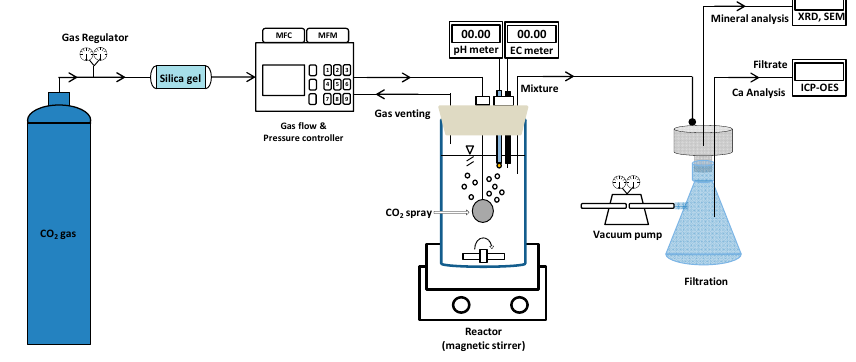
Figure 3. A schematic experimental flow diagram of the carbon mineralization process (MFC: mass flow controller; MFM: mass flow management system; EC: